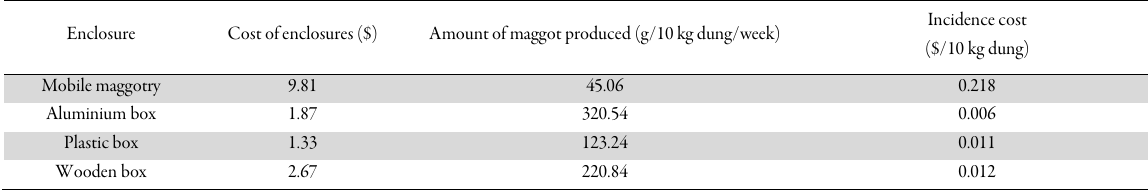
Fig. 5. Mean weekly weight of maggot produced from various enclosures AB = Aluminium box; AMM = Aluminium mobile maggotry; PB = Plastic box; WB = Wooden box Table 3. Cost of maggot production from the various culture